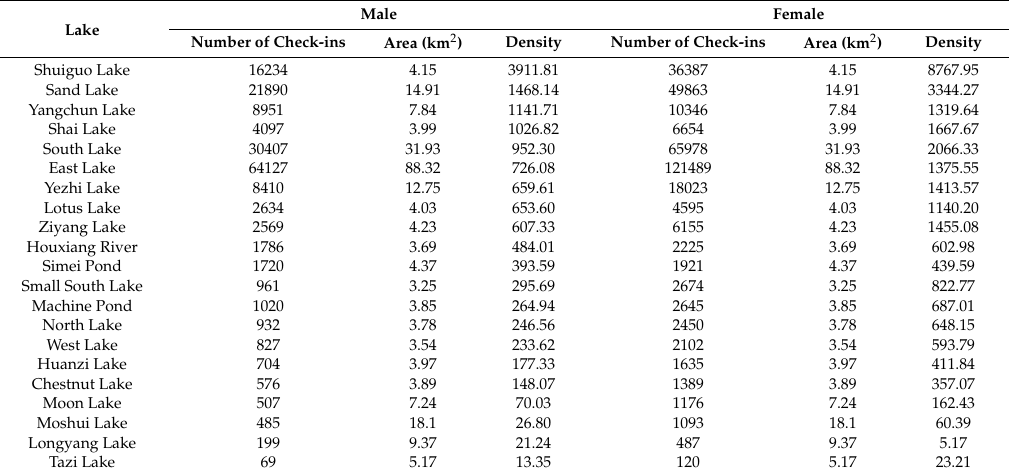
Table 2. Density of male users’ check-in points in the bu ff er zone of each Table 1. Gender differences in weekday and weekend check-in numbers.